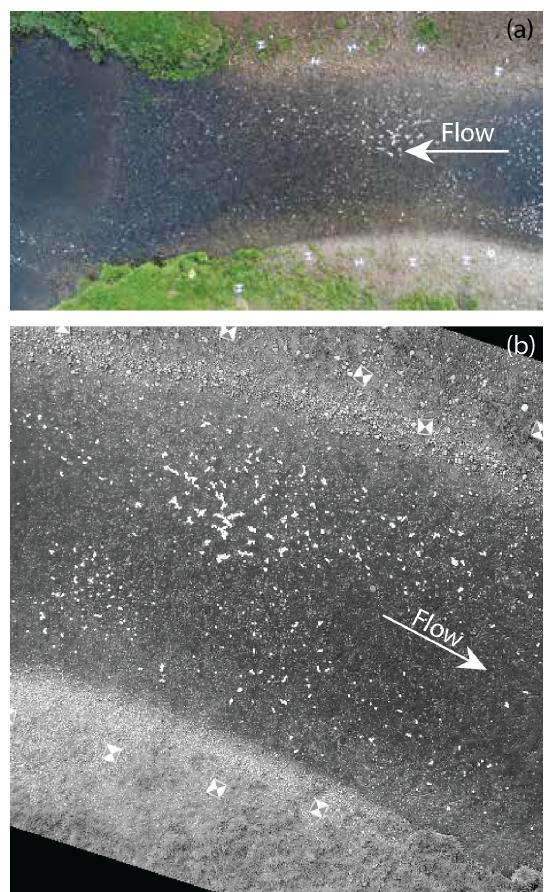
Figure 2. (a) Footage acquired by the Phantom 4 UAS over the River Arrow and (b) following orthorectification and greyscale con- version. The Ecofoam chips and ground control points are clearly visible in both images. The direction of flow is indicated by the ar-